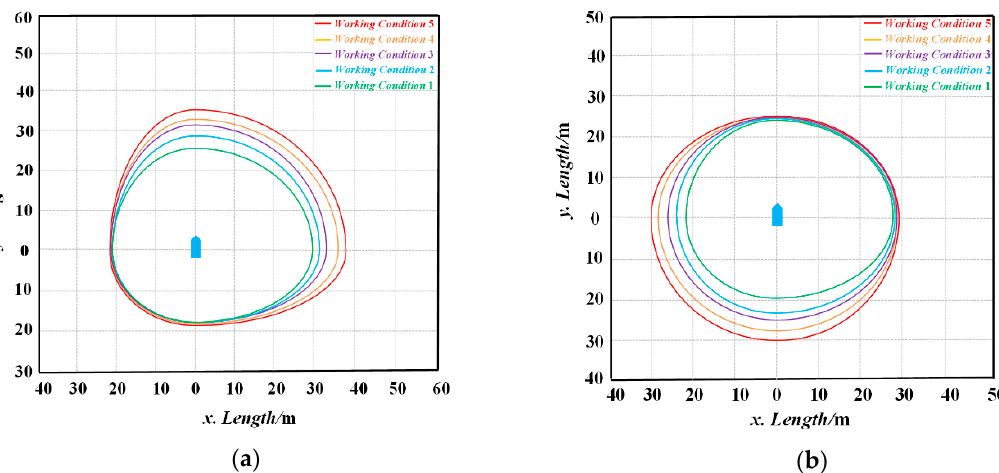
Figure 13. Radius changes of the DNSD in the overtaken situation: ( a ) Under the first angle groups; ( b ) Under the second angle groups. ( b ) Under the second angle